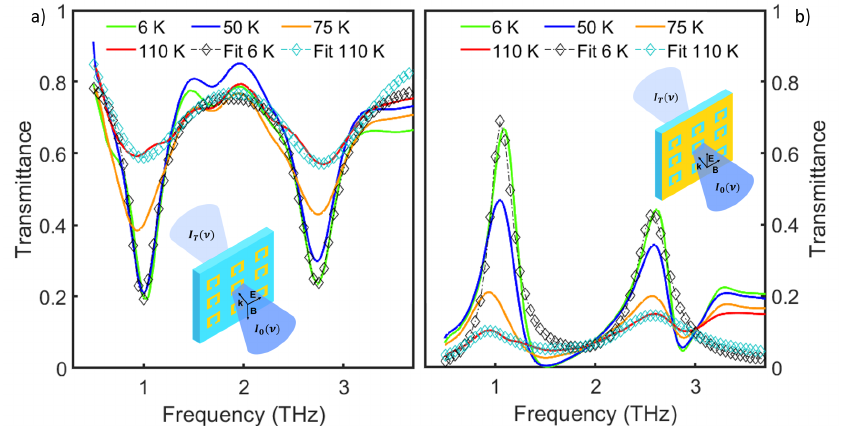
Figure 2. Experimental transmittance spectra for direct ( a ) and complementary ( b ) SRR arrays at different temperatures. In both cases, the fitting curves (empty symbols) at 6 K and 110 K are reported, too. The insets show a sketch of the optical measurement configuration for direct ( a ) and complementary ( b ) SRR arrays with the corresponding electric field polarization: perpendicular with respect to the SRR gap ( a ), and parallel with respect to the complementary SRR gap ( b ). Yellow areas indicate YBCO, and light-blue areas indicate Al 2 O 3 substrate. I 0 ( ν ) indicates the incoming radiation, whereas I T ( ν ) indicates the transmitted